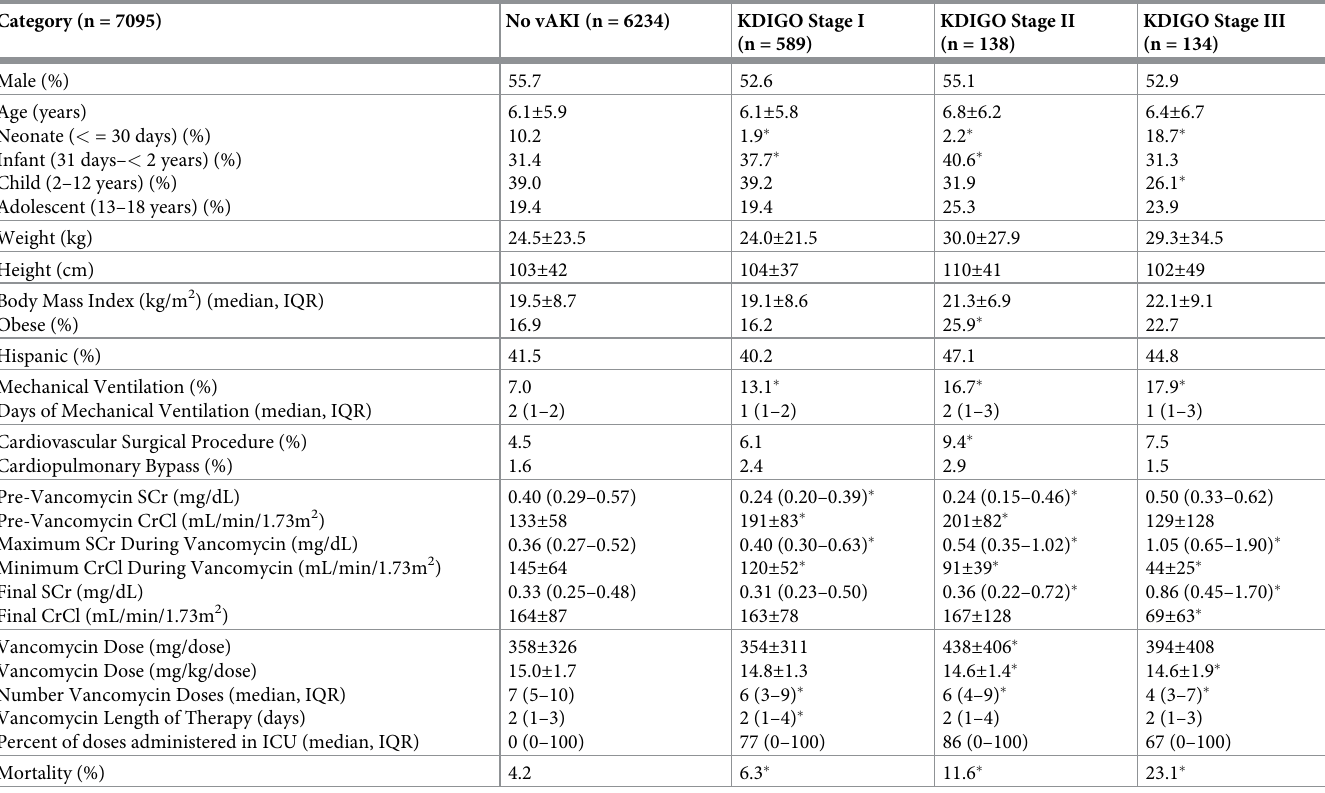
Table 2. Comparison of patient demographic variables by AKI